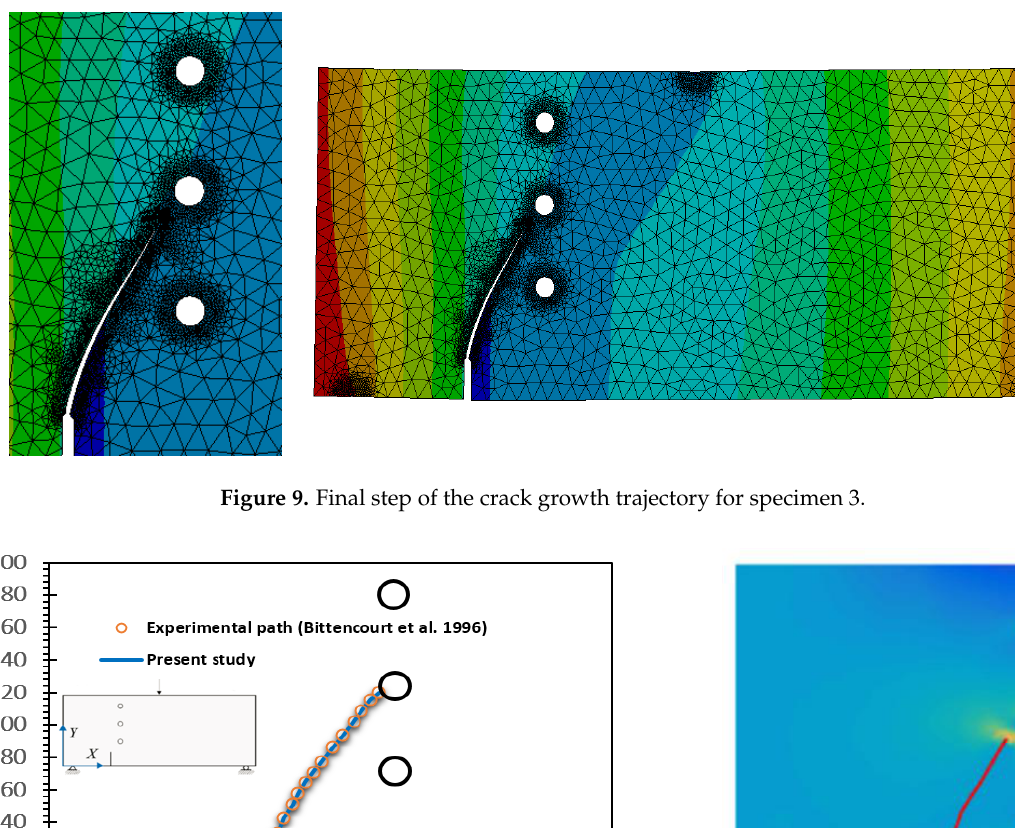
Figure 8. Ansys and experimental crack trajectory for crack tip coordinate of specimen 2.